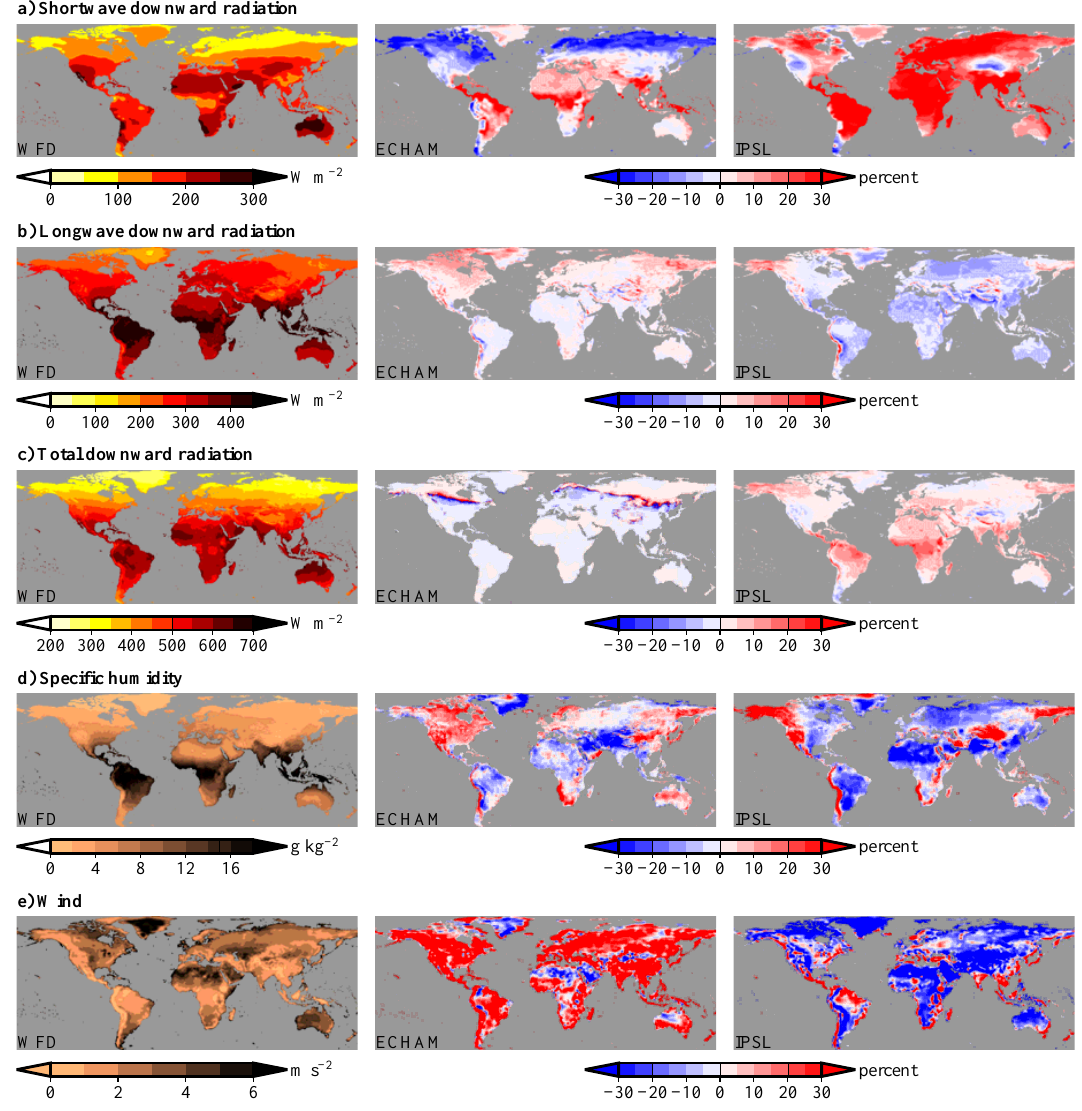
Figure 1: Mean annual (1971-2000) WFD forcings and climate model anomalies. a) 2 Fig. 1. Mean annual (1971–2000) WFD forcings and climate model anomalies. (a) Shortwave downward radiation, (b) longwave downward radiation, (c) Total downward radiation, (d) Specific humidity and (e) Wind Shortwave downward radiation, b) Longwave downward radiation, c) Total downward 3 radiation, d) Specific humidity and e) Wind speed. 4